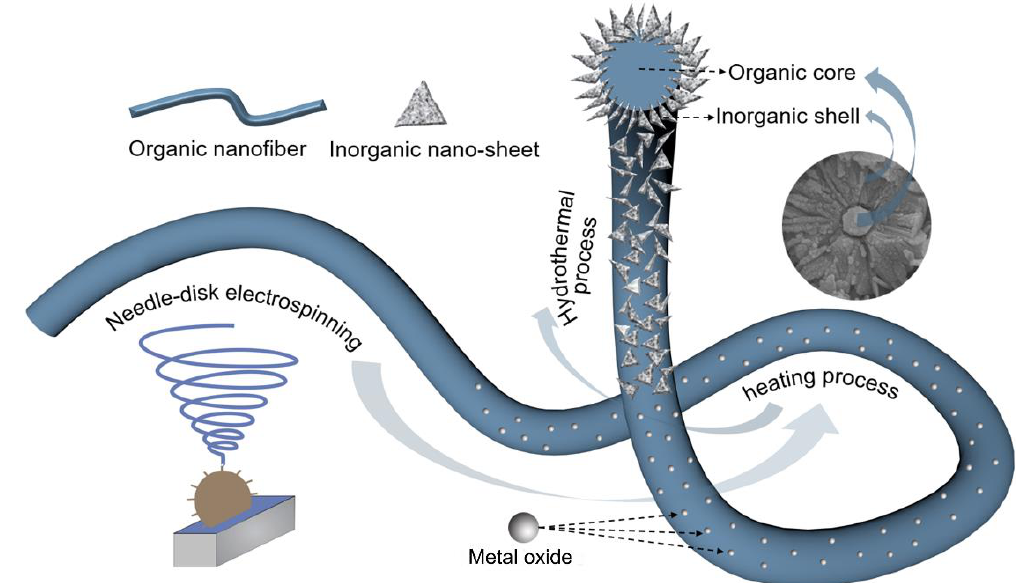
Figure 1. Schematic diagram of the evolution of the P/CuO-nanosheet membrane.